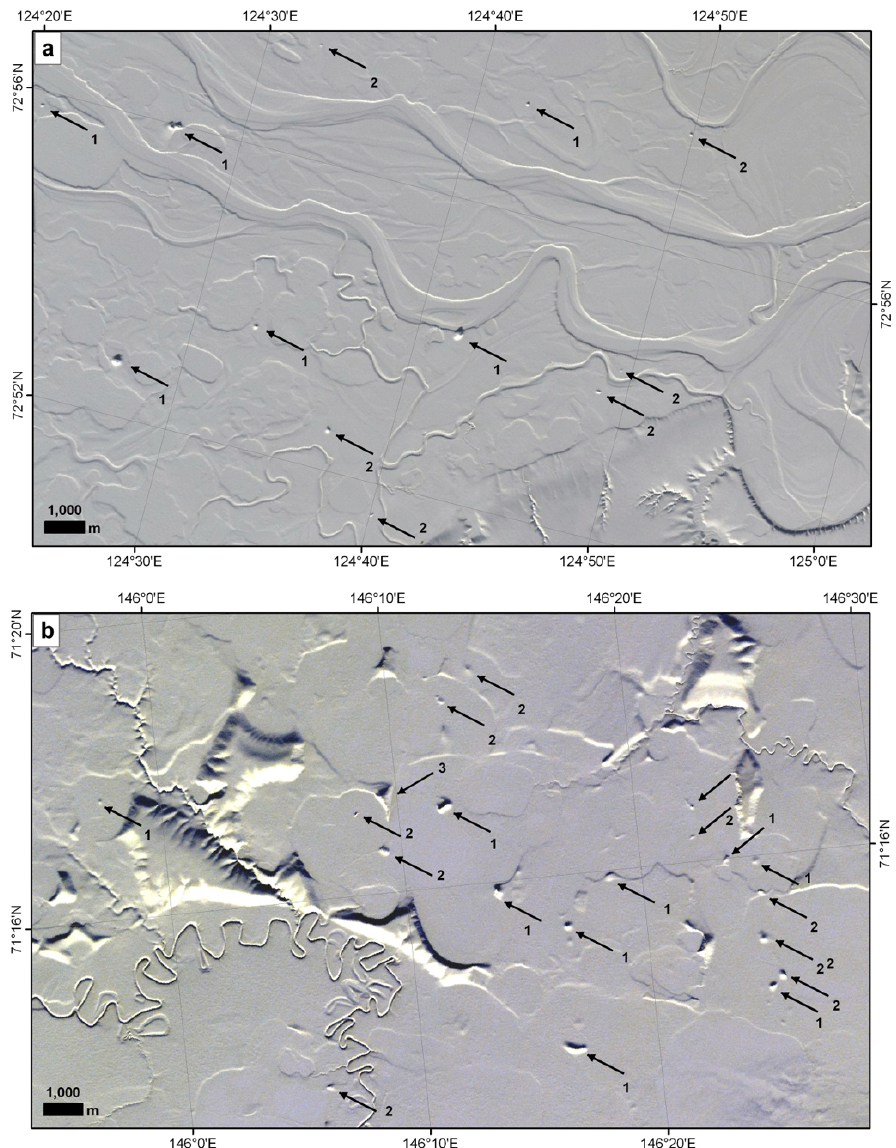
Fig. 4. Mapping of pingos using Terra ASTER late winter imagery for assessment of completeness of pingo locations in 1:200000 to- pographic maps. (a) – Fluvial floodplain of the first terrace of the Lena River Delta with numerous pingos (black arrows); (b) –